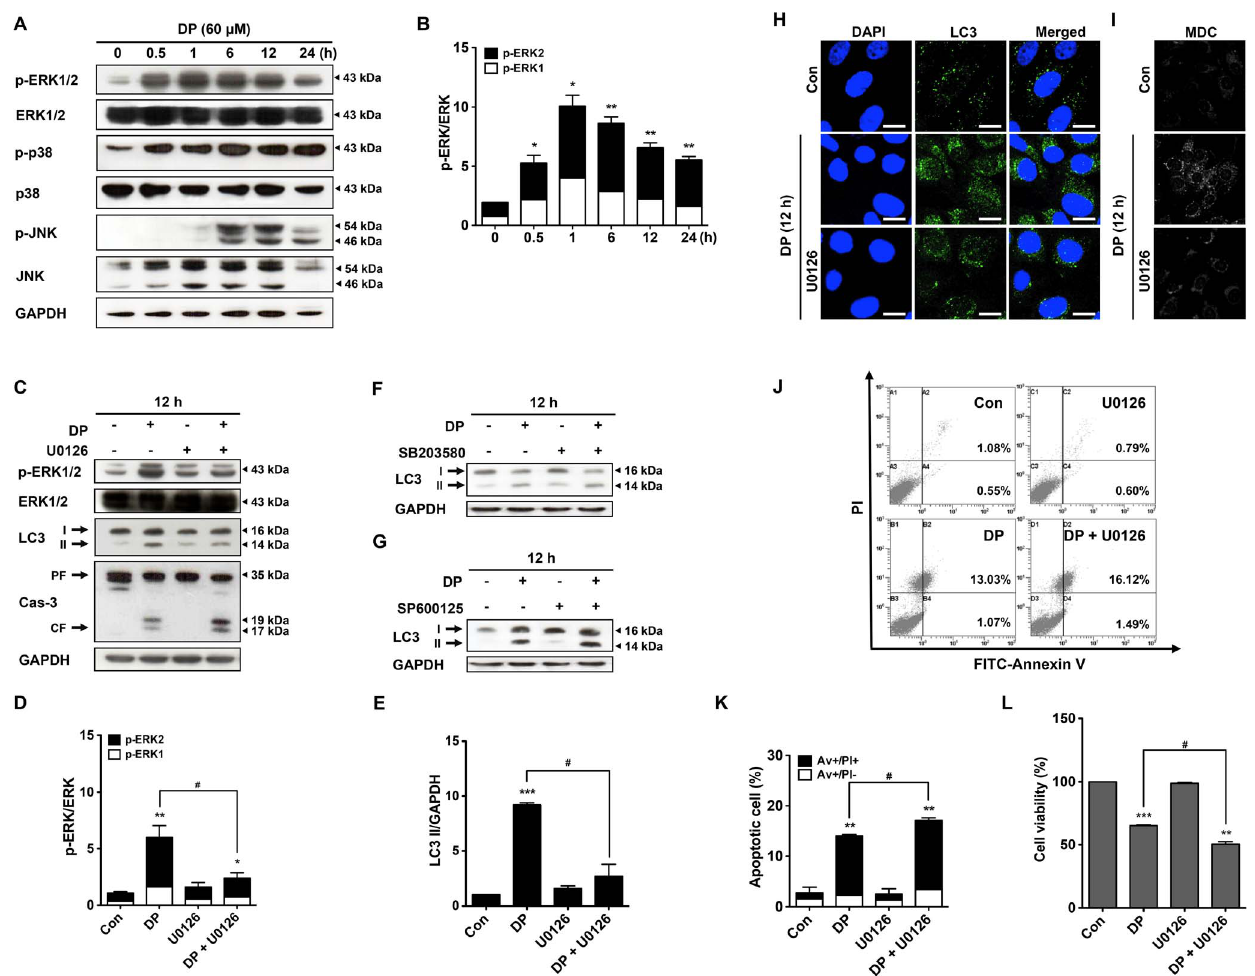
Figure 5. DP induced autophagy through ERK1/2 signaling pathway. For representative immunoblot analysis of p-ERK1/2, ERK1/2, p-p38, p38, p-JNK and JNK protein expression levels, cells were treated with 60 m M dendropanoxide (DP) for different times (A). (B) Densitometric analysis of p-ERK/ERK in Fig. 5A. MG-63 cells were treated with 60 m M DP for 12 h in the presence or absence of 50 m M U0126 and then protein expression levels of p-ERK1/2, ERK1/2, LC3-II and caspase-3 were analyzed by immunoblotting (C). (D) Densitometric analysis of p-ERK/ERK in Fig. 5C. (E) Densitometric analysis of LC3-II/GAPDH in Fig. 5C. Cells were incubated with 60 m M DP for 12 h in the presence or absence of 20 m M SB203580 and then protein expression level of LC3-II was analyzed by immunoblotting (F). For representative immunoblot analysis of LC3-II protein expression levels, cells were treated with 60 m M DP for 12 h in the presence or absence 10 m M SP600125 (G). MG-63 cells were incubated with 60 m M DP for 12 h in the presence or absence 50 m M U0126, after fixation, the nuclei were stained with DAPI (blue), and the distribution of endogenous LC3 (anti-LC3 FITC; green) was detected by confocal microscopy (scale bars: 20 m m) (H) . Autophagic vacuoles were stained with MDC (bright color), and observed with fluorescence microscopy (I). The percentage of apoptotic cell was evaluated by flow cytometry using Annexin V/PI staining (J). Quantitative analysis of Av + /PI-